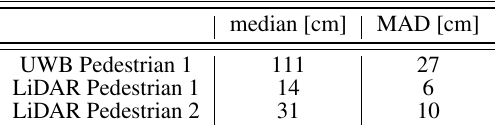
Table 1. 2D positioning results. LiDAR refers only to those time instants when the Pedestrian were detectable (e.g. not occluded).